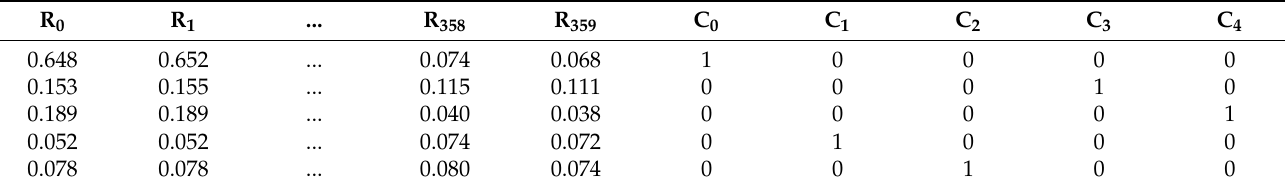
Table 2. Part of Training Dataset.